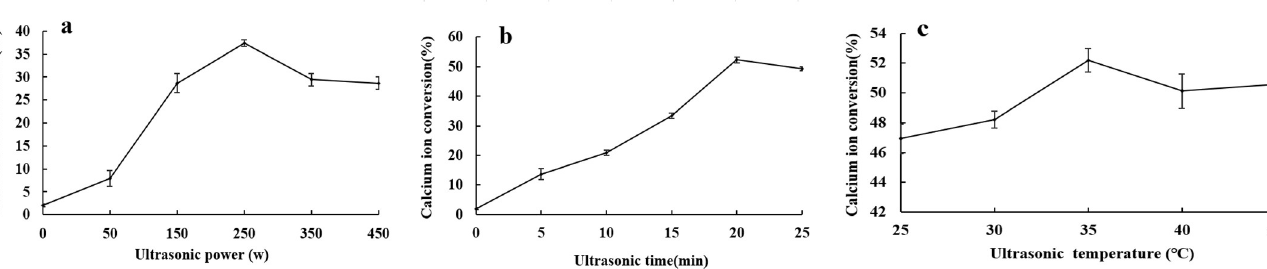
PLOS ONE | https://doi.org/10.1371/journal.pone.0254583 July 15,